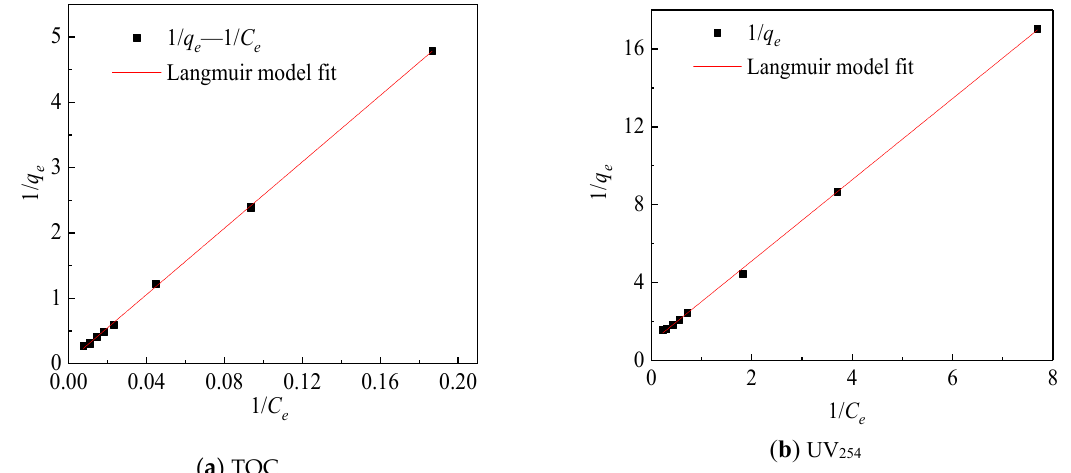
Figure 5. Freundlich model fitting map.